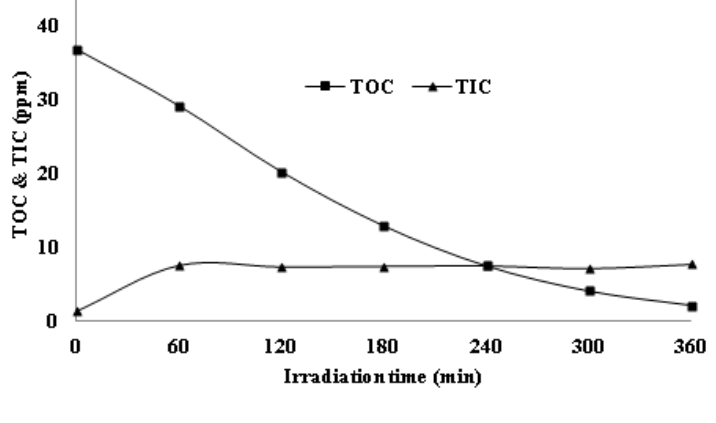
Figure 9. The amount of total organic carbon (TOC) and total inorganic carbon (TIC) during photocatalic degradation of p -cresol under UV irradiation, initial condition; p -cresol concentration = 50 ppm, ZnO = 2.5 g/L and pH =